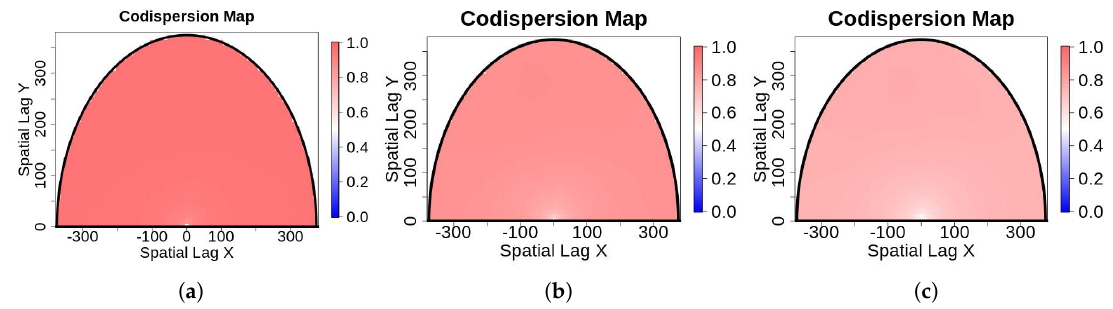
Figure 7. Codispersion map between (a) the original Figure 1a,c (5%); (b) the original Figure 1a,e (15%); (c) the original Figure 1a,g